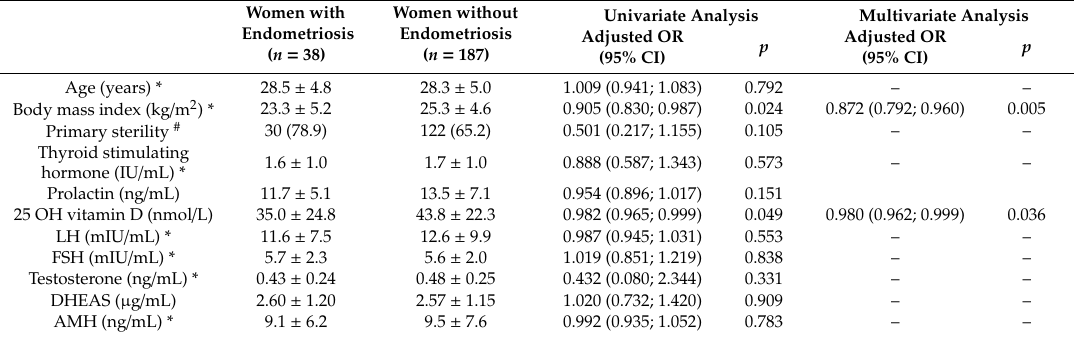
Table 3. General patient characteristics and hormonal profile in women with CC-resistant PCOS with and without